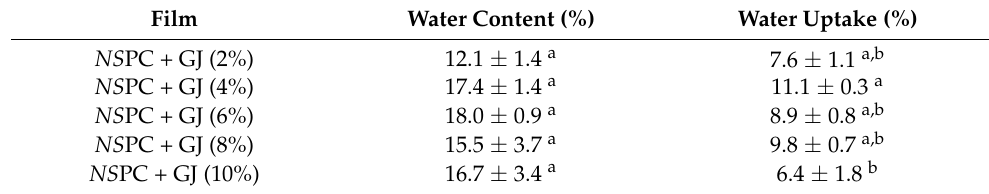
Table 3. Water content and uptake of NS PC prepared with different concentrations of grape juice (GJ). Film Water Content